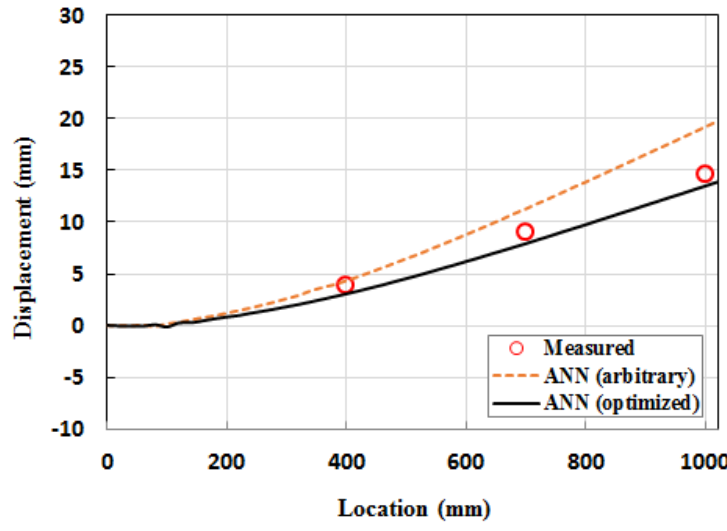
Figure 21. Overall displacements shape at time = 1.5 s.